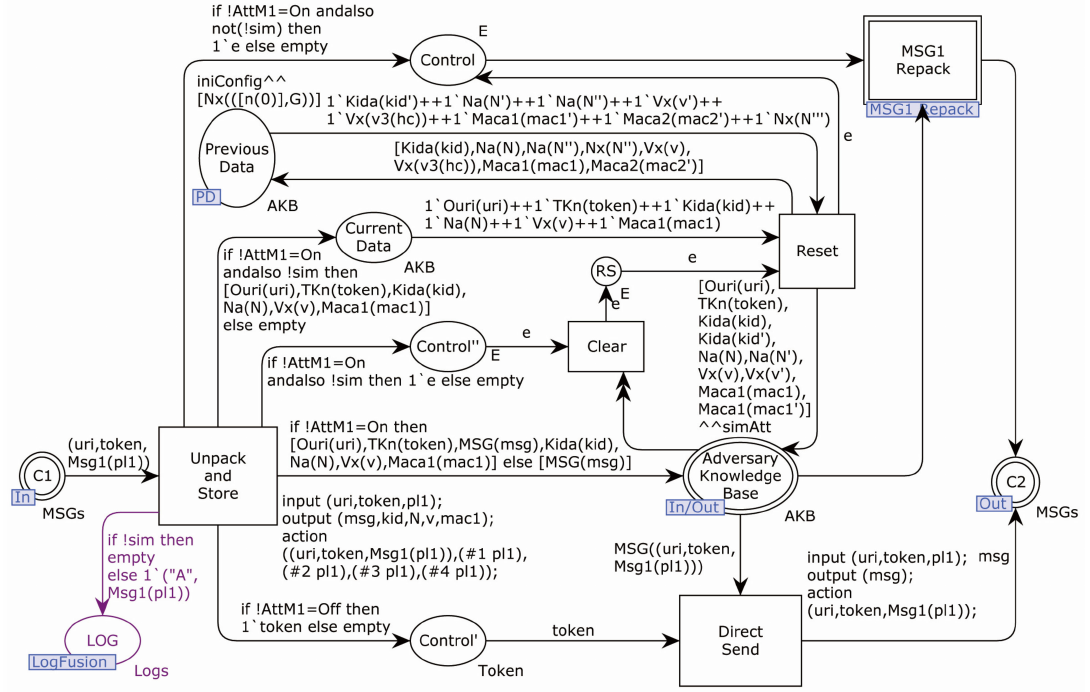
Figure 13. Adversary model sub-page MSG1_Hacking.